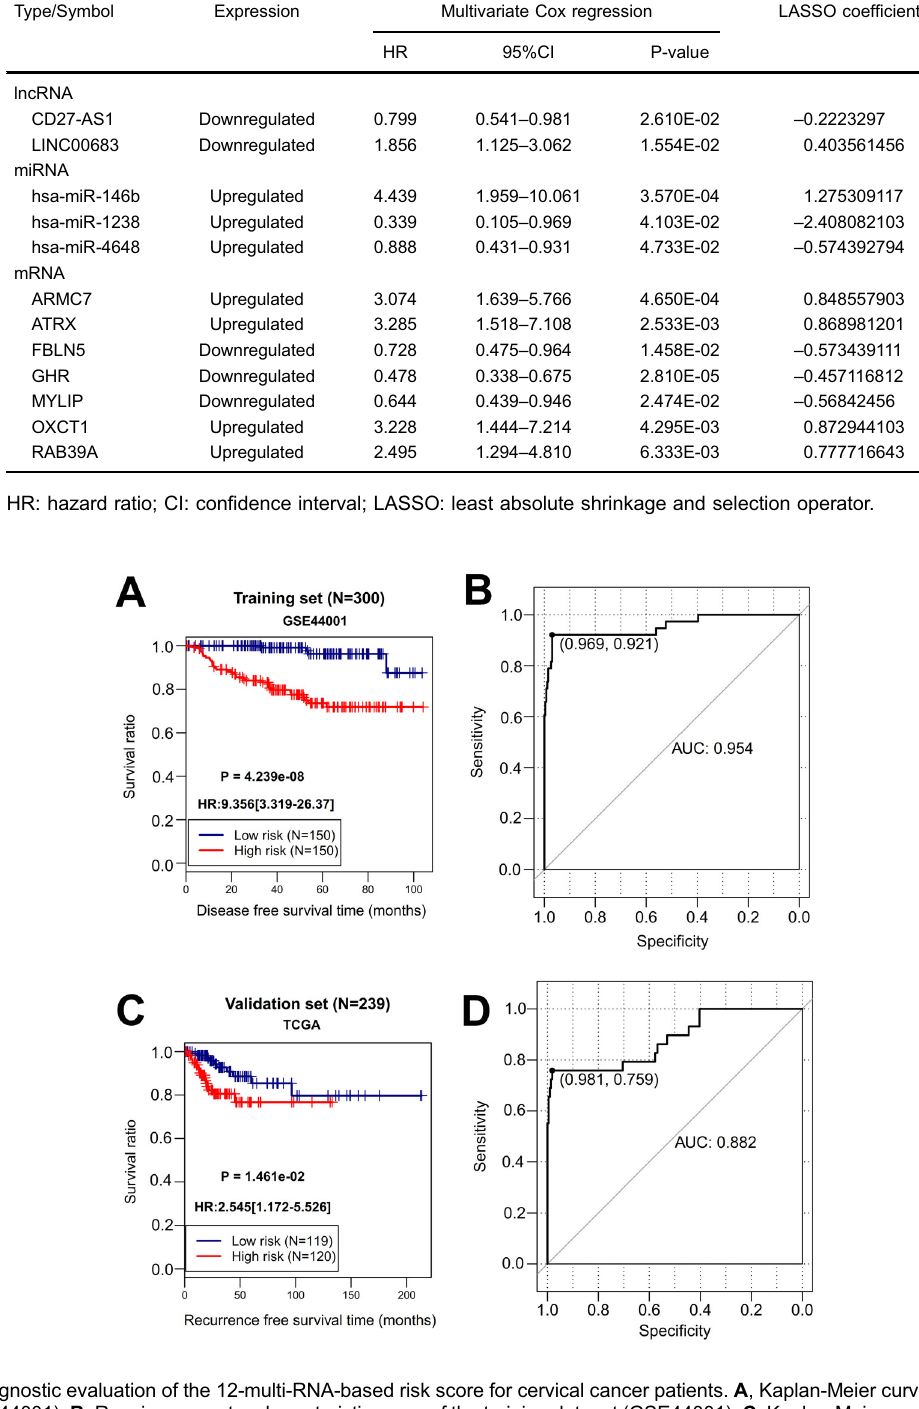
Figure 4. Prognostic evaluation of the 12-multi-RNA-based risk score for cervical cancer patients. A , Kaplan-Meier curve of the training dataset (GSE44001). B , Receiver operator characteristic curve of the training dataset (GSE44001). C , Kaplan-Meier curve of the testing dataset (TCGA). D , Receiver operator characteristic curve of the testing dataset (TCGA). AUC: area under the receiver operator characteristic curve; HR: hazard